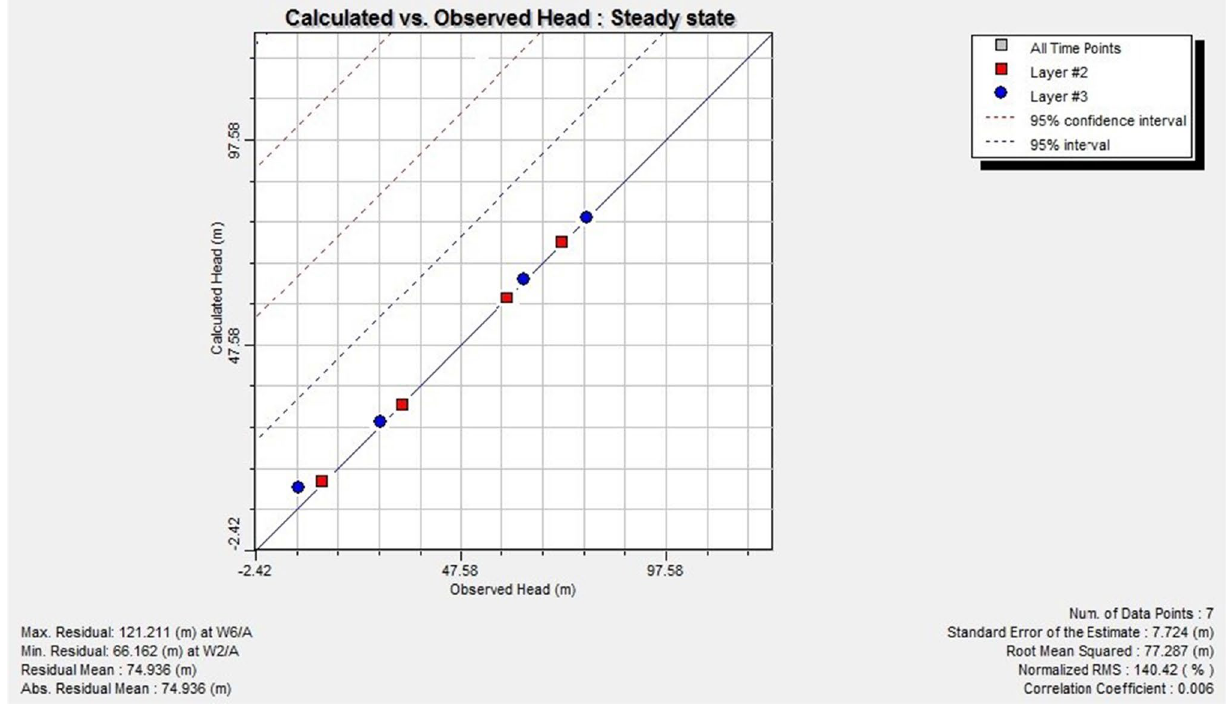
Fig. 11 Calculated vs observed head using steady-state